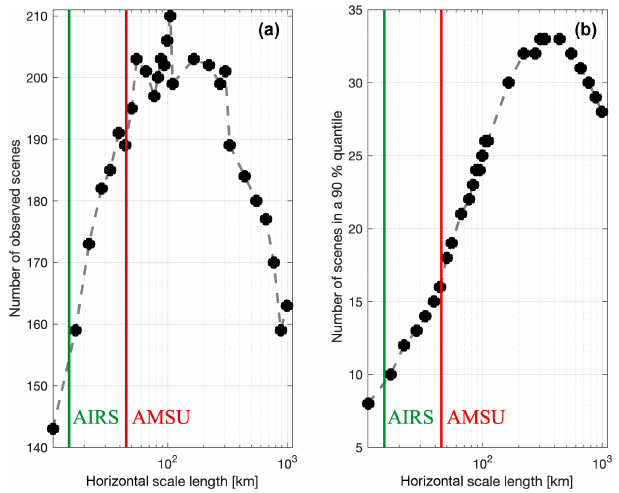
Figure 3. (a) Number of observed scenes as a function of the hor- izontal length scale used to define the scene. (b) Number of scenes observed at the 90th percentile as a function of horizontal length scale used to define the scene. The vertical green (red) lines approx- imate the scale of the AIRS (AMSU) pixel